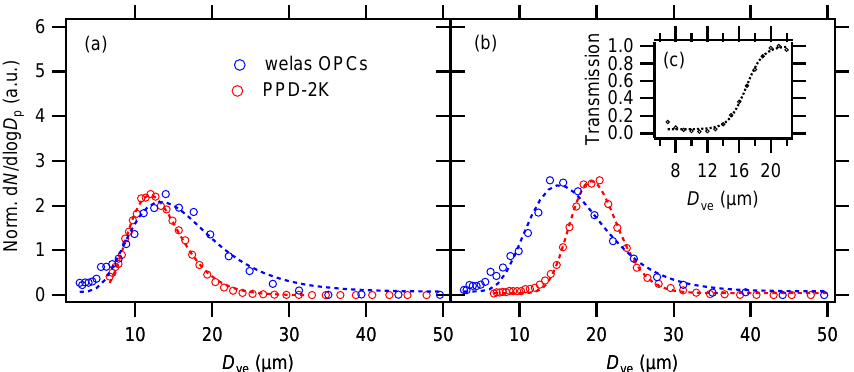
Figure 13. Normalized size distribution of ice particles for INUIT05_55 (static mode) (a) and INUIT05_56 (CF mode)) (b) . Size distributions were measured at two locations: the welas OPCs in the chamber and the PPD-2K after the IS-PCVI. d N /dlog D p normalized to the total number concentration measured in each instrument is plotted as a function of ice particles in D ve . The size correction factor of 4.5 was applied to the welas OPC (see text for more details). The PPD-2K size distribution was normalized to the same maximum of the welas OPC size distribution. Both panels a and b represent a snapshot picture of 1 min average size distribution with sufficient amount of ice crystals observed in AIDA [11:01:15–11:02:15 ) (a) and 12:21:15–12:22:15 (b) ; see also Figs. 12a.iii and 12b.iii]. Subpanel c shows